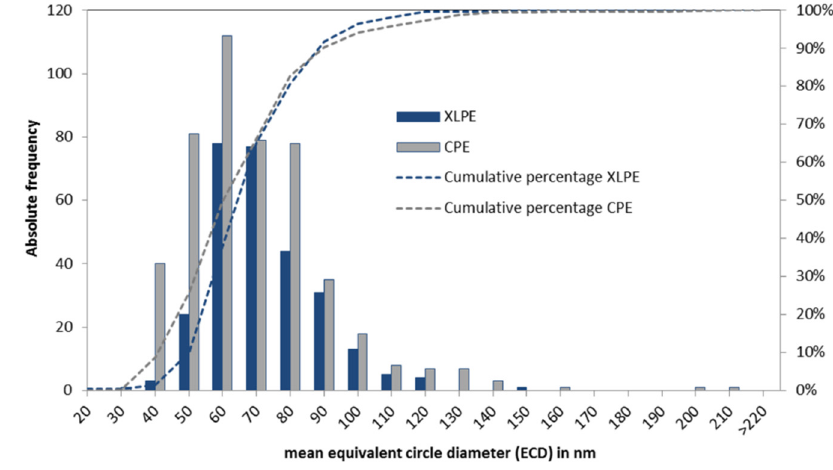
Figure 4. The size distribution of the analyzed particles from the CPE and XLPE inserts.